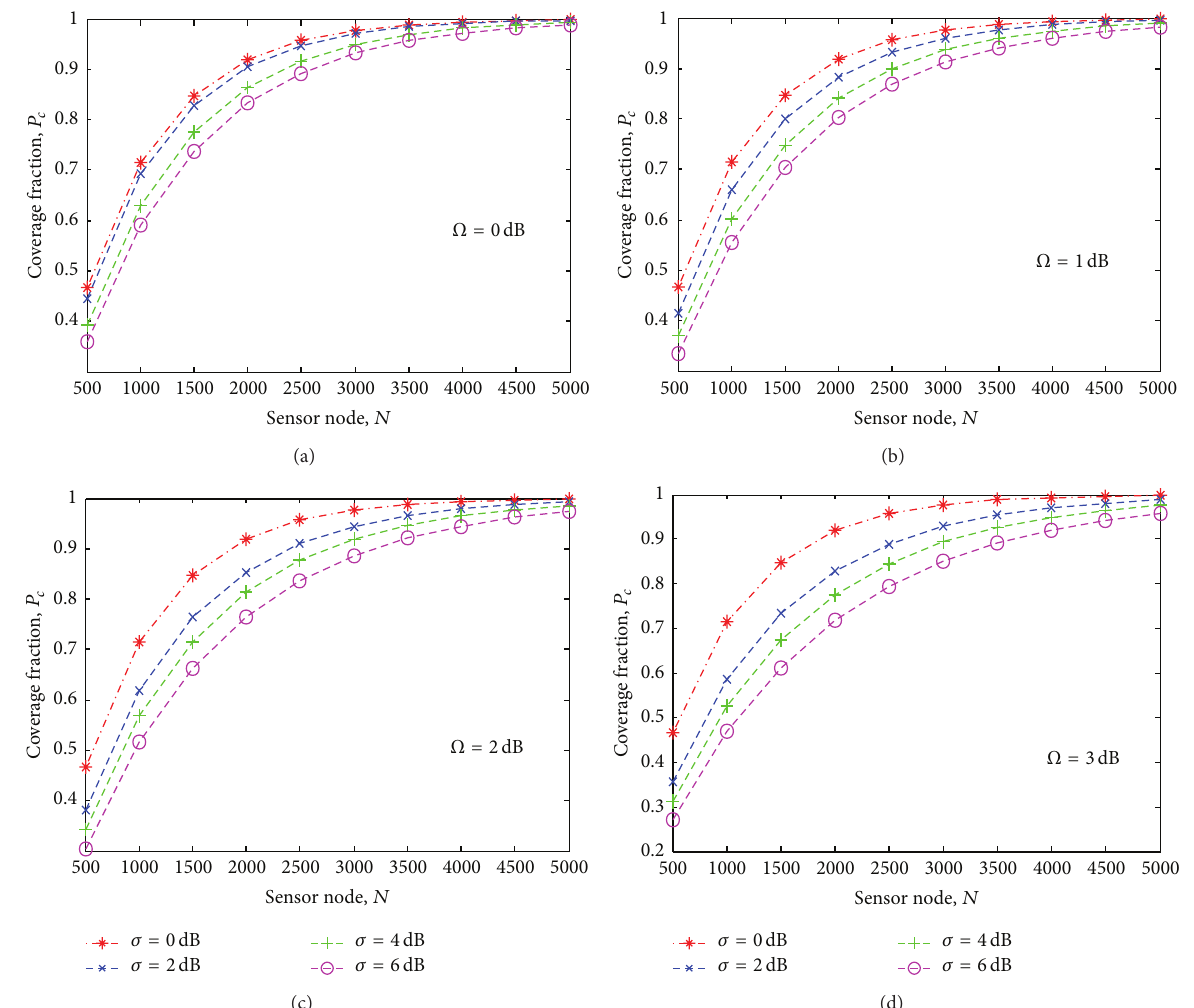
Figure 5: Coverage probability 𝑃 𝑐 versus number of sensor nodes 𝑁 for different shadowing and multipath environments.